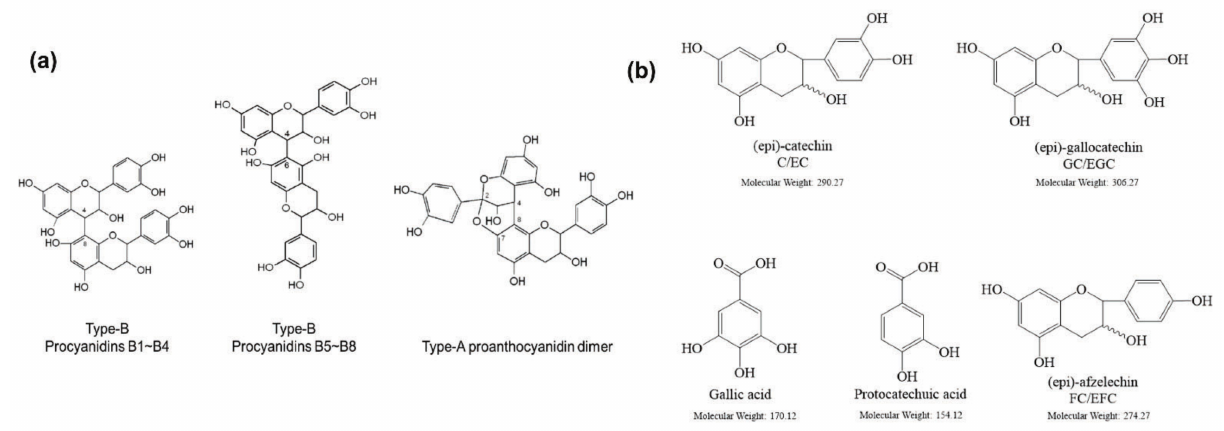
Figure 2. ( a ) Structure of Type-A and Type-B proanthocyanidin dimers. ( b ) Structure of esterified monomers and